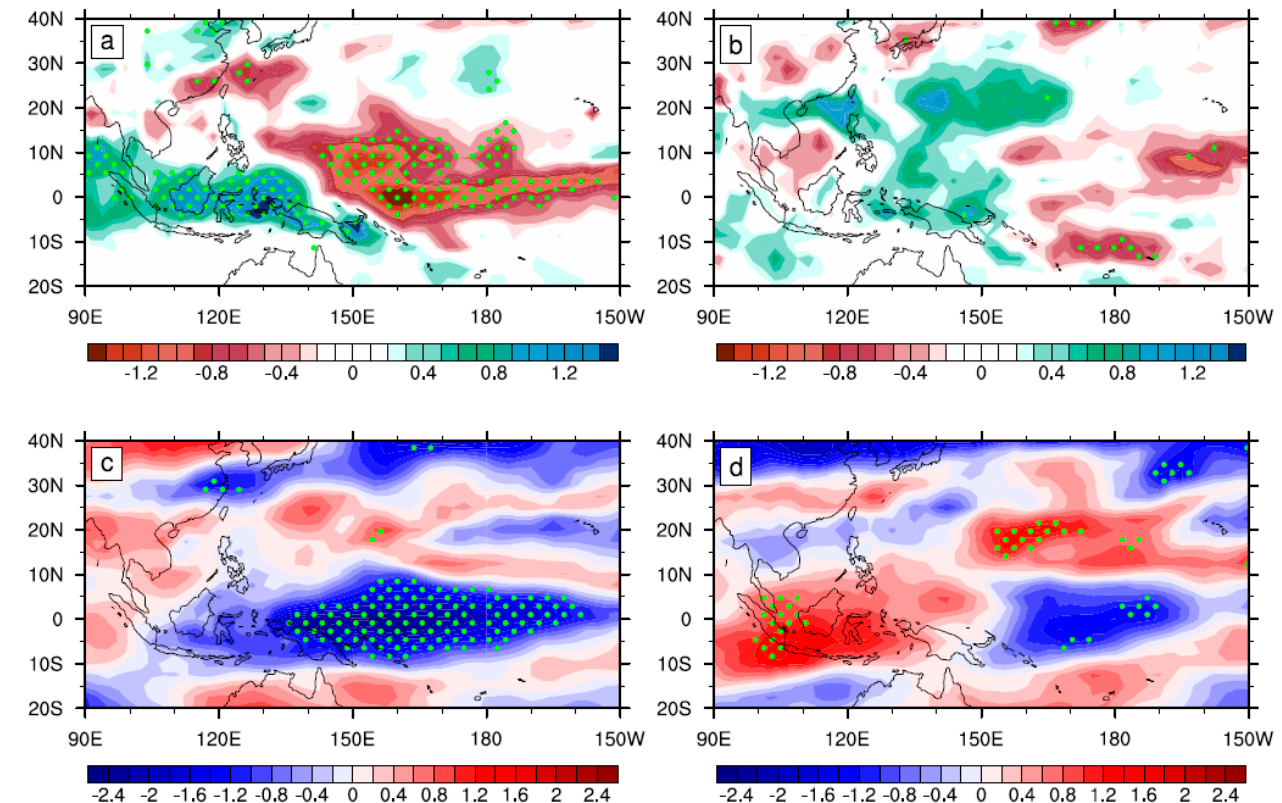
Figure 5. Regression of ( a , b ) surface precipitation rate (shading, mm/day) and ( c , d ) vertical wind shear (shading, m/s; 200 hPa minus 850 hPa) anomalies in JJA onto the normalized JFM SH index during ( a , c ) 1980–2002 and ( b , d ) 2003–2020. The green dots in ( a – d ) denote the significant surface precipitation rate and vertical wind shear anomalies above the 95% confidence level based on the two-sided Student’s t-test, respectively.